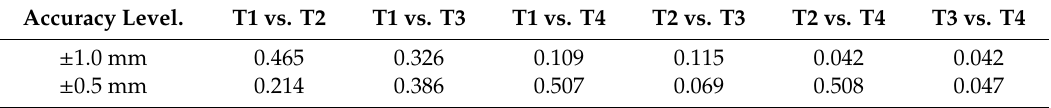
Table 2. p’ -Values of the Wilcoxon test performed for multiple comparison. Accuracy